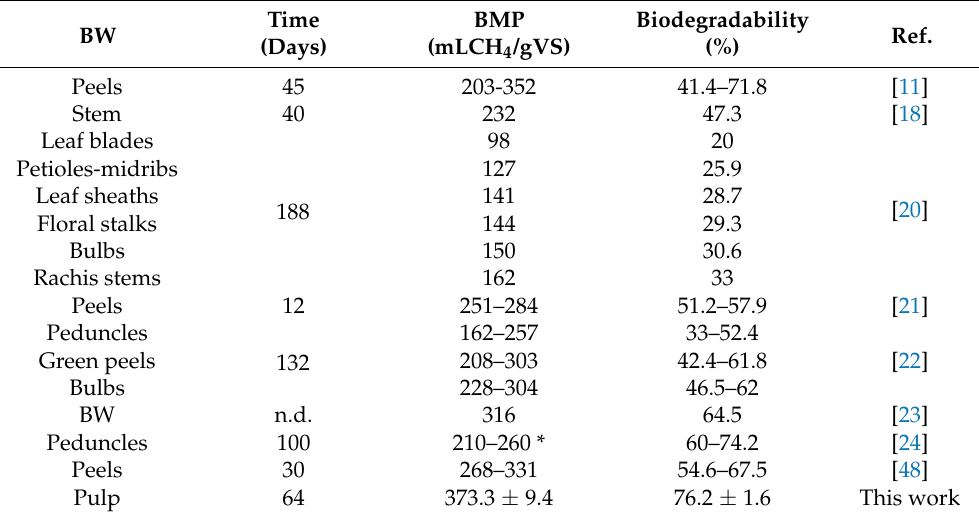
Table 2. BMP and biodegradability reported by previous